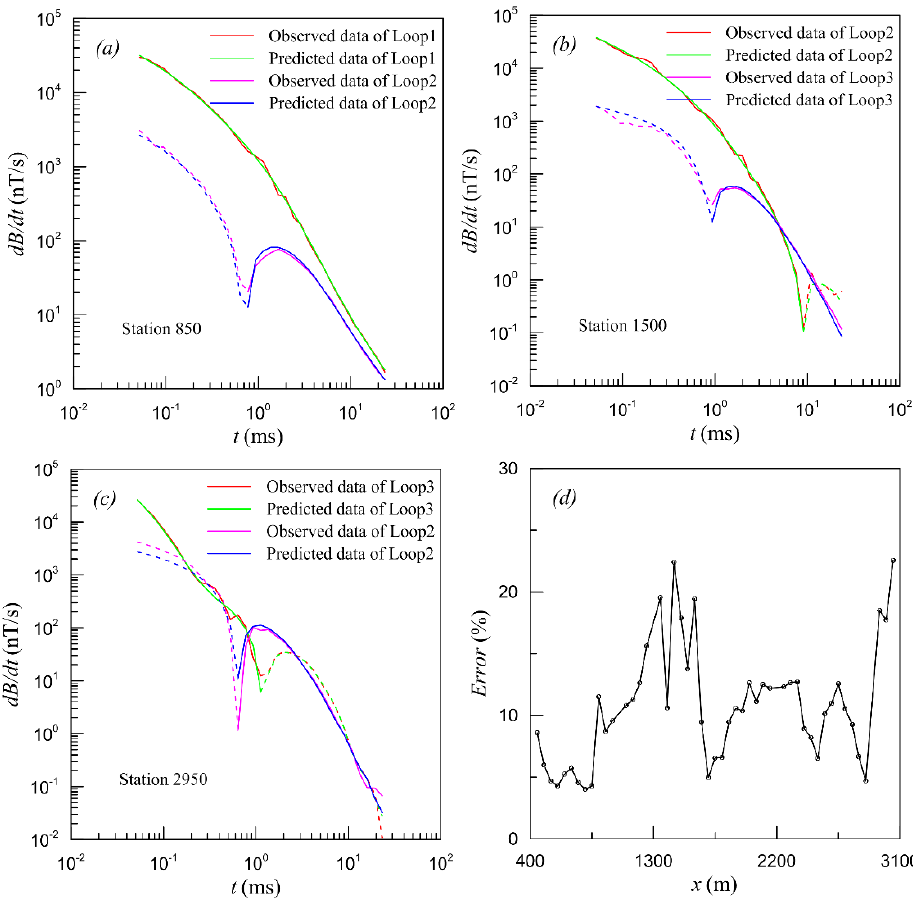
Figure 8. Fitting curves and fitting error of different stations. ( a ) Fitting curves of station 850; ( b ) Fitting curves of station 1500; ( c ) Fitting curves of station 2950; ( d ) Fitting errors of all stations.